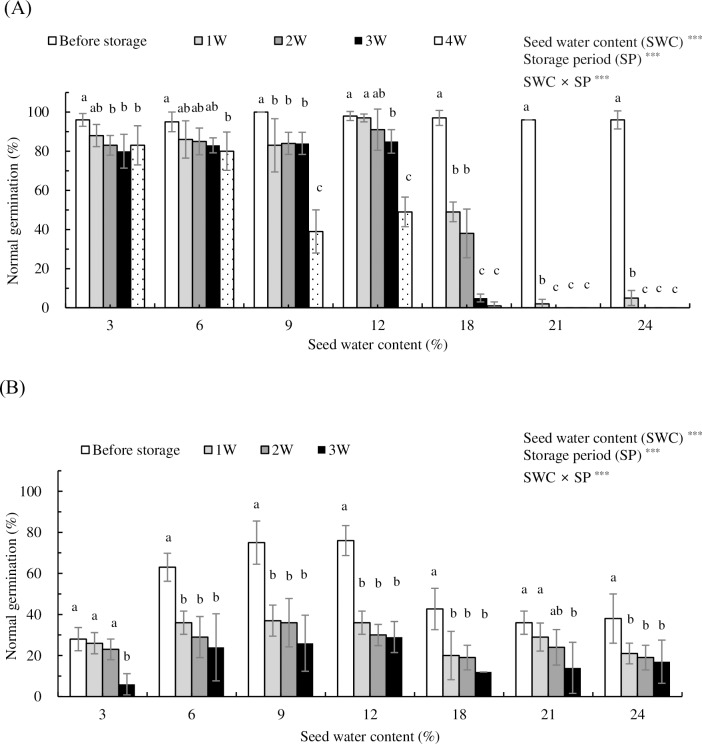
Rates of normal seed germination before storage (0 W) and after 1–4 weeks (1 W–4 W) of storage at room temperature for P. davidiana (A) and P. koreana (B). Seed water contents were 3%, 6%, 9%, 12%, 18%, 21%, and 24% (fresh weight basis). Different letters indicate statistically significant differences among five storage periods within each seed water content at p<0.05, according to Duncan’s multiple range test. Vertical bars represent means of four replicates ± SD (n = 4). ***p<0.001.